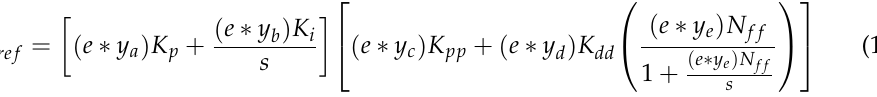
Figure 6. Input MFs of fuzzy system.